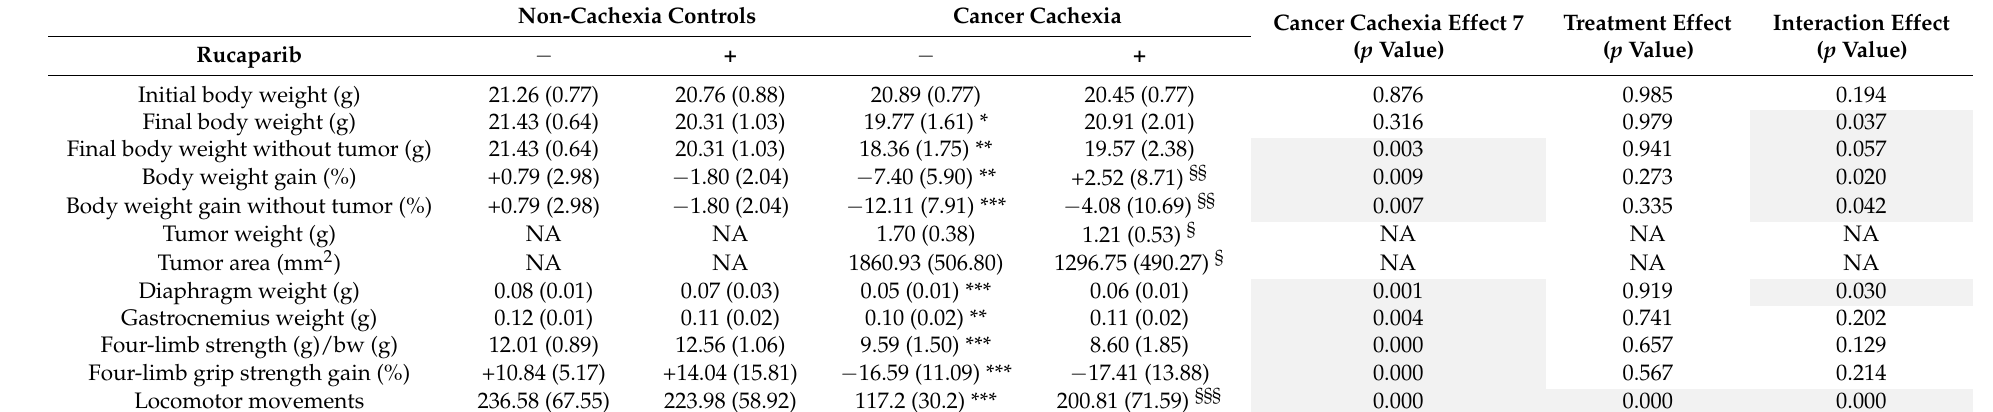
Table 1. Physiological parameters in all experimental groups of